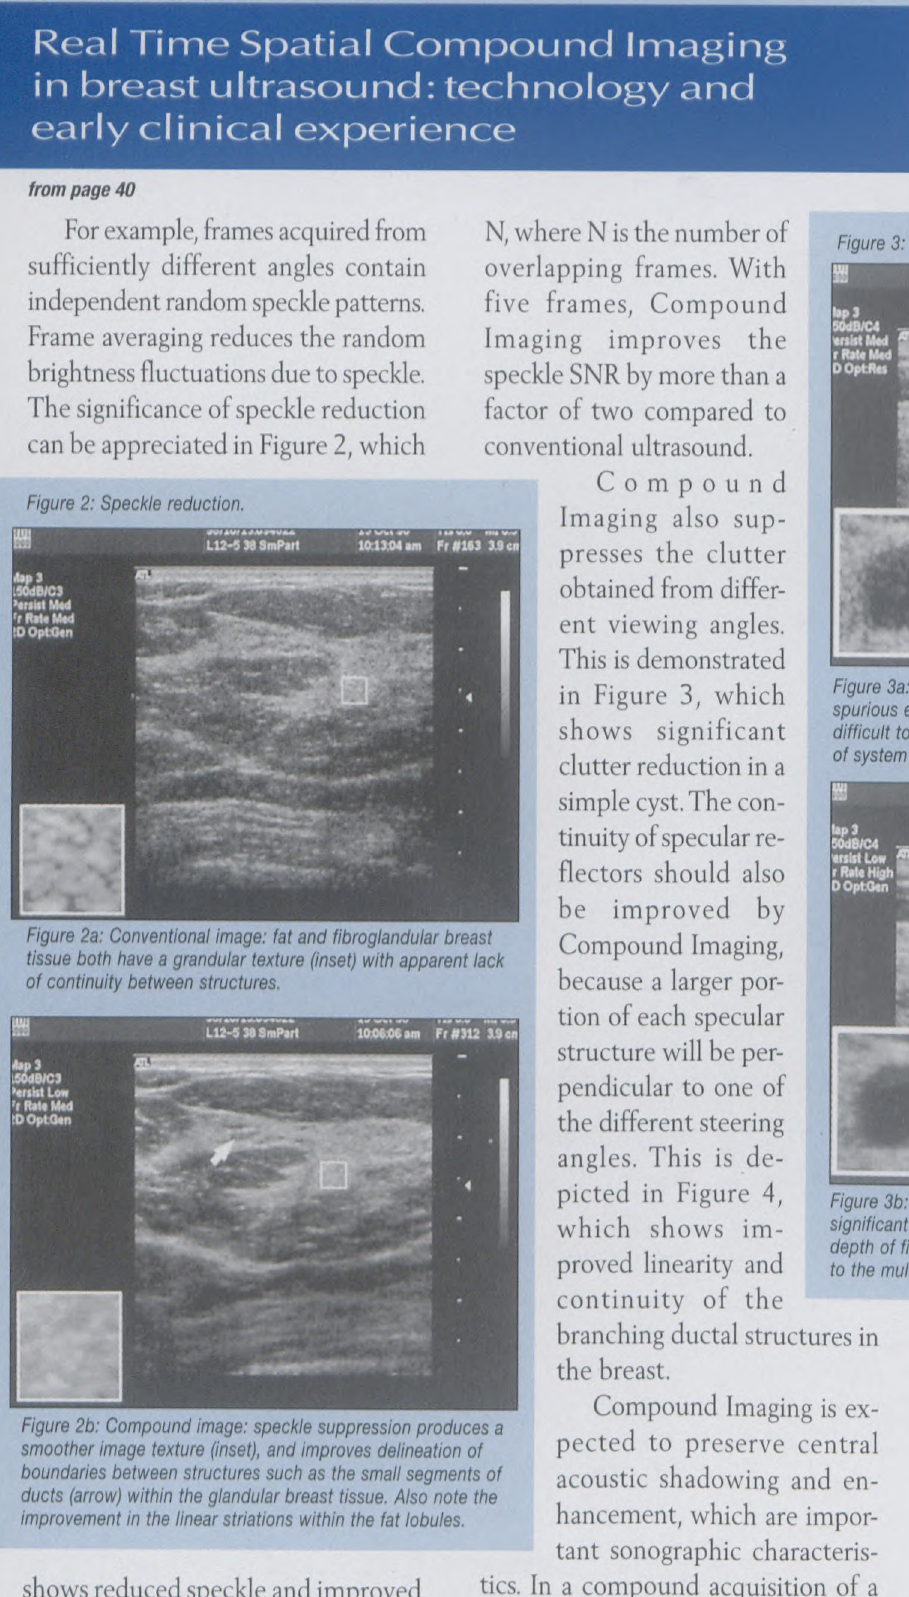
Figure 2b: Compound image: speckle suppression produces a smoother image texture (inset), and Improves delineation of boundaries between structures such as the small segments of ducts (arrow) within the glandular breast tissue. Also note the Improvement in the linear striations within the fat lobules.